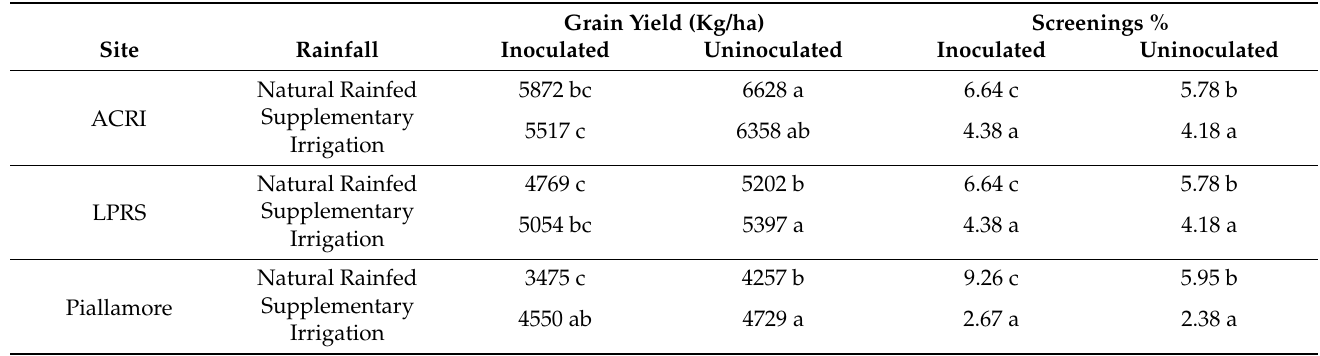
Table 1. Grain yield and screenings of three bread (LRPB Lancer, Suntop and LRPB Hellfire) and three durum (DBA Lillaroi, Jandaroi and DBA Aurora) wheat varieties when inoculated or uninoculated with Fusarium crown rot under natural rainfed and supplementary irrigation scenarios across three trial sites; Australian Cotton Research Institute (ACRI), Liverpool Plains Research Site (LPRS) and Piallamore, in 2020. Values within a site followed by the same letter are not significantly difference at the 95% confidence interval.